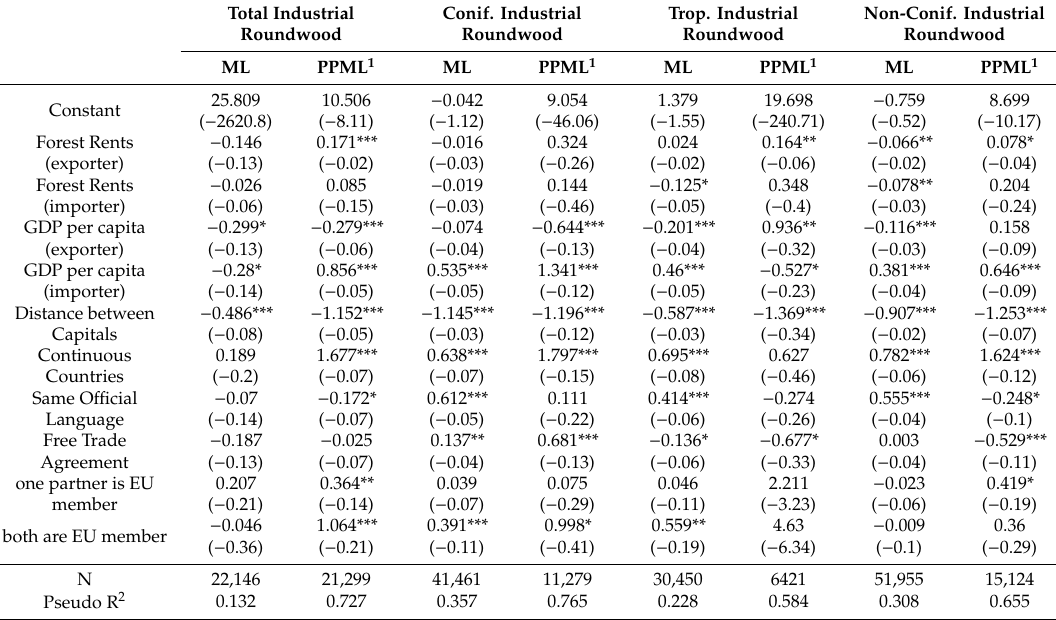
Table A2. Estimation results for the product group ‘industrial roundwood’.